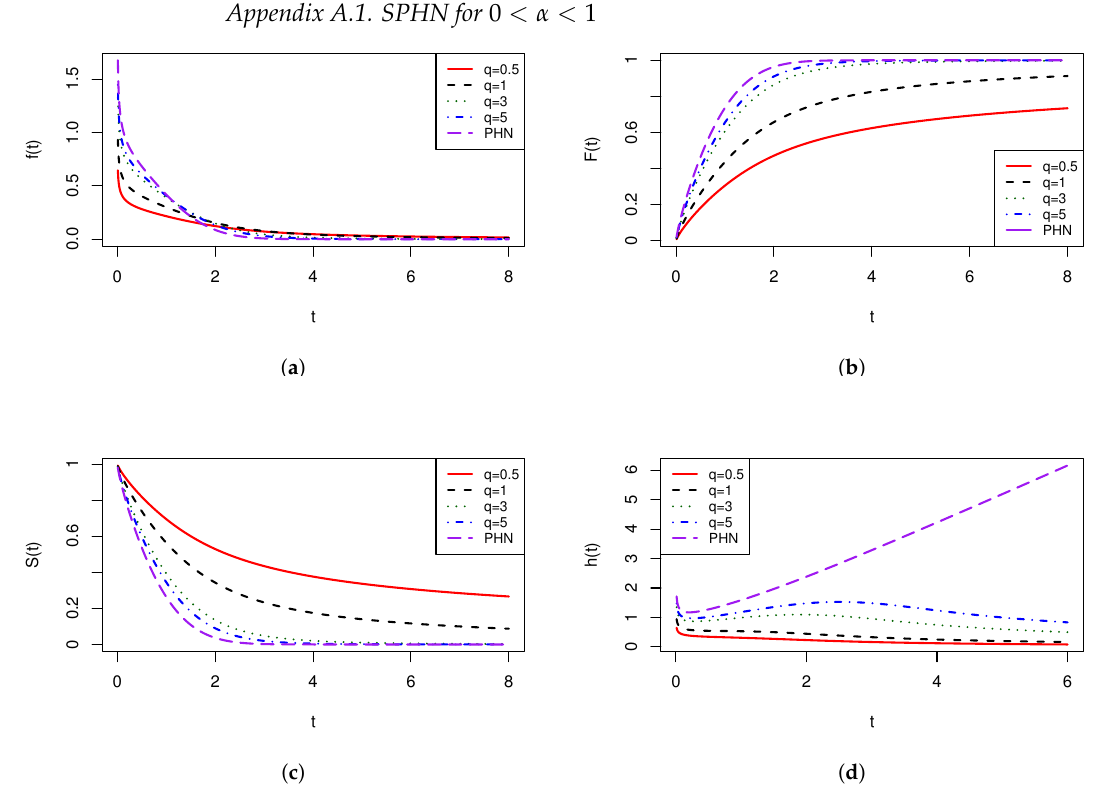
Figure A1. SPHN ( 1, α = 0.8, q ) for different values of q . In all panels, q = 0.5 (red), q = 1 (black), q = 3 (green), q = 5 (blue), and q = ∞ (purple). ( a ) pdf of SPHN ( 1, α = 0.8, q ) . ( b ) cdf of SPHN ( 1, α = 0.8, q ) . ( c ) Survival function of SPHN ( 1, α = 0.8, q ) . ( d ) hazard rate function of SPHN ( 1, α = 0.8, q ) .